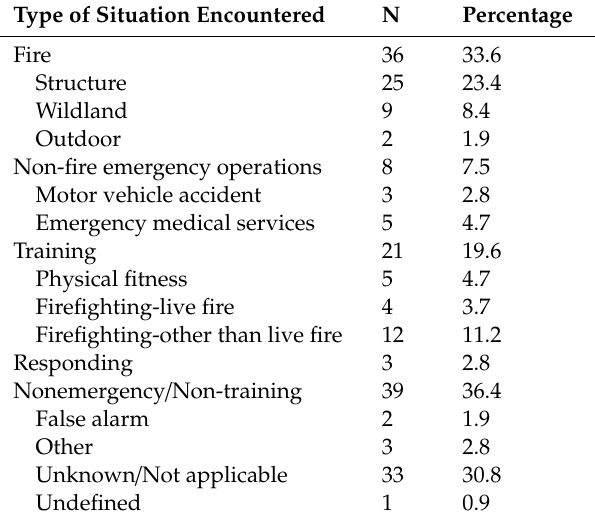
Table 3. Type of situation encountered among cardiac-related fatalities investigated by NIOSH for incidents that occurred 9 January 2008–10 February 2017 (N = 107).